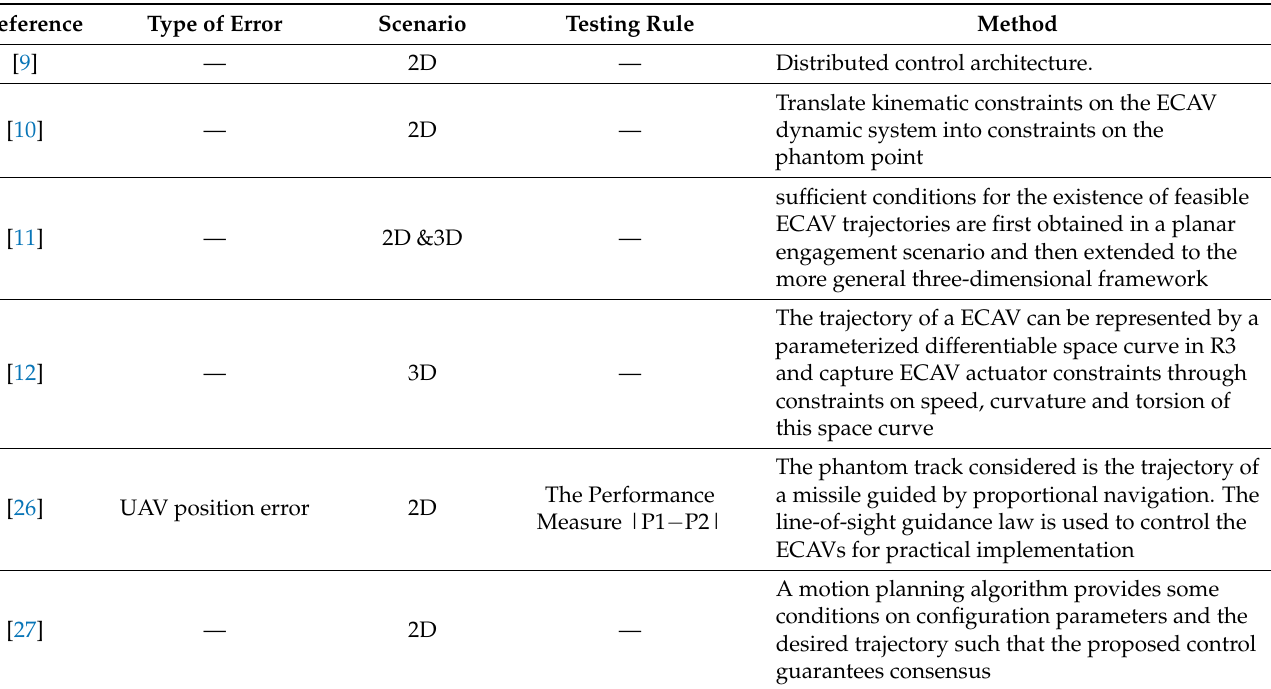
Table 3. Related work by Indian scholars.